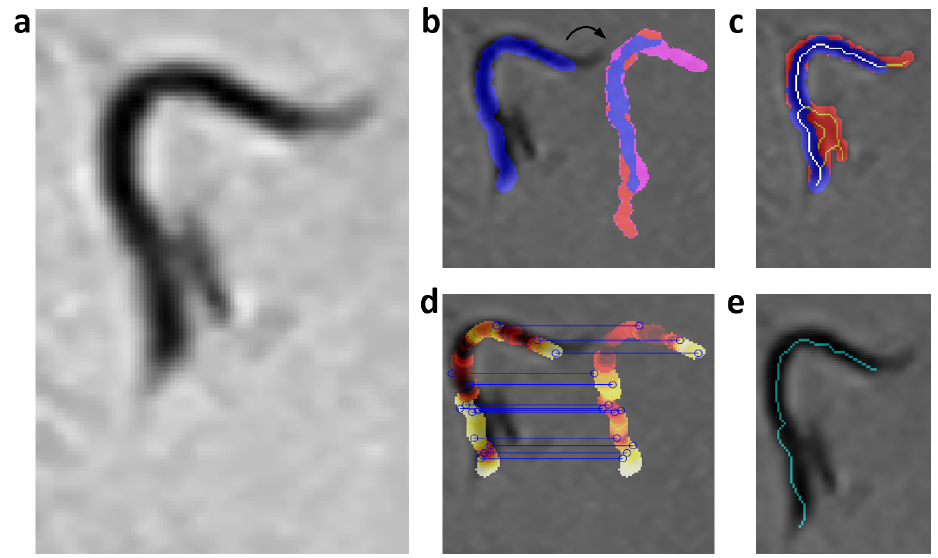
Figure A9. Model 7 evaluation, example 3. The yellow and white pixels are the resulting skeleton using the improved form of skeletonizing. The white pixels are the pixels of the skeleton prediction, which are used to reconstruct the body of each worm (segmentation in blue and green). ( a ) Grayscale image. ( b ) Overlap criterion evaluation. ( c ) Completeness criterion evaluation. ( d ) Color criterion evaluation. ( e ) Optimization result.